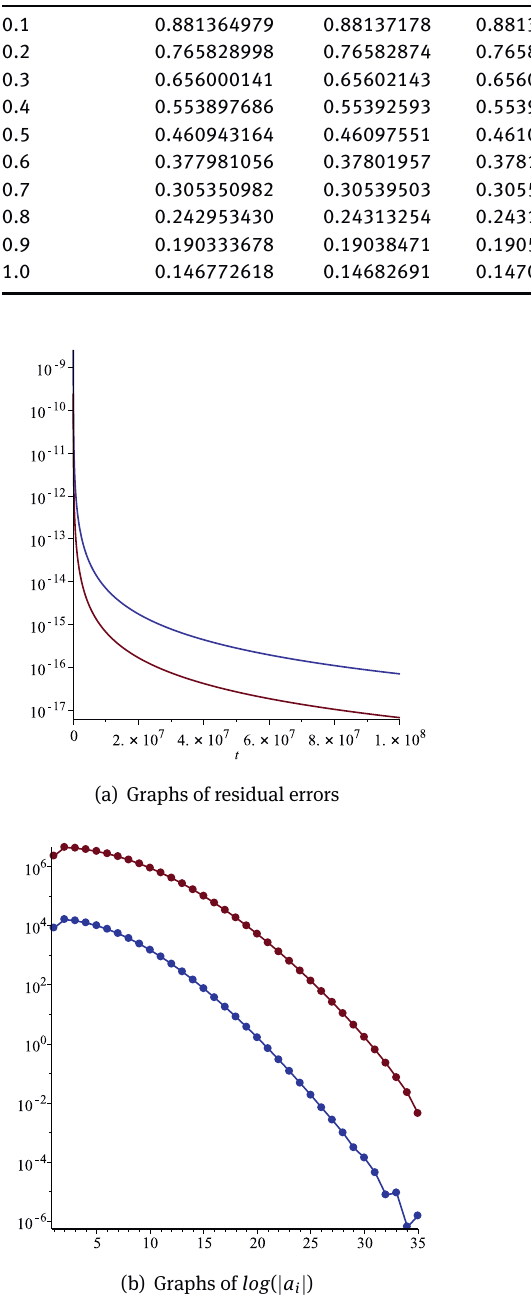
Fig. 3: Graphs of residual errors and log( | a i | ) for β = 0.50 (Blue) and β = 0.75